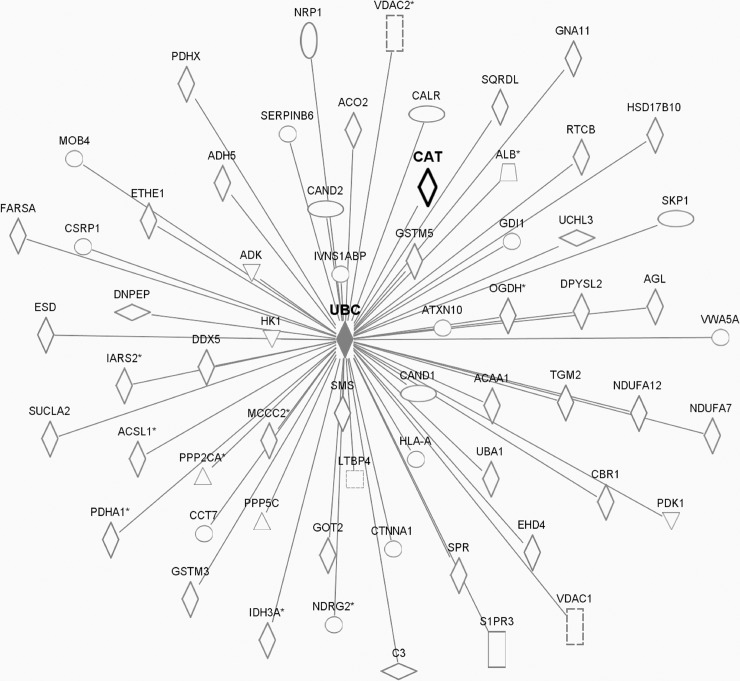
Pathway analysis-predicted protein networks associated with ubiquitin c (Ubc).Legend to network analysis: enzyme (diamond), transmembrane receptor (vertical oval), transcriptional regulator (horizontal oval), phosphatase (triangle), transporter (trapezoid), kinase(triangle), growth factor (square), and other (circle). Relationships: interaction (line), activation (arrow).